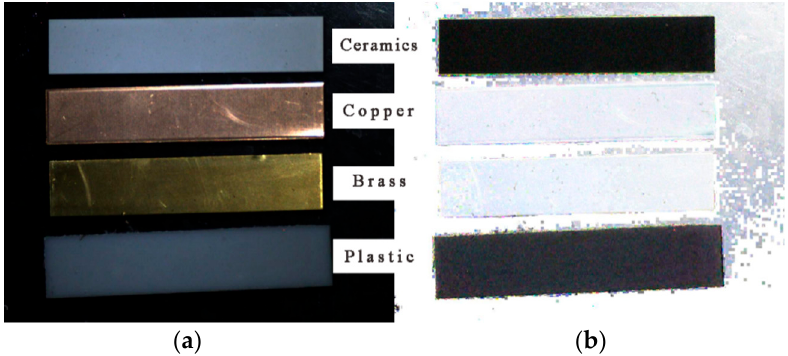
Figure 9. Image I and image DOP of different materials: ( a ) image I; ( b ) image